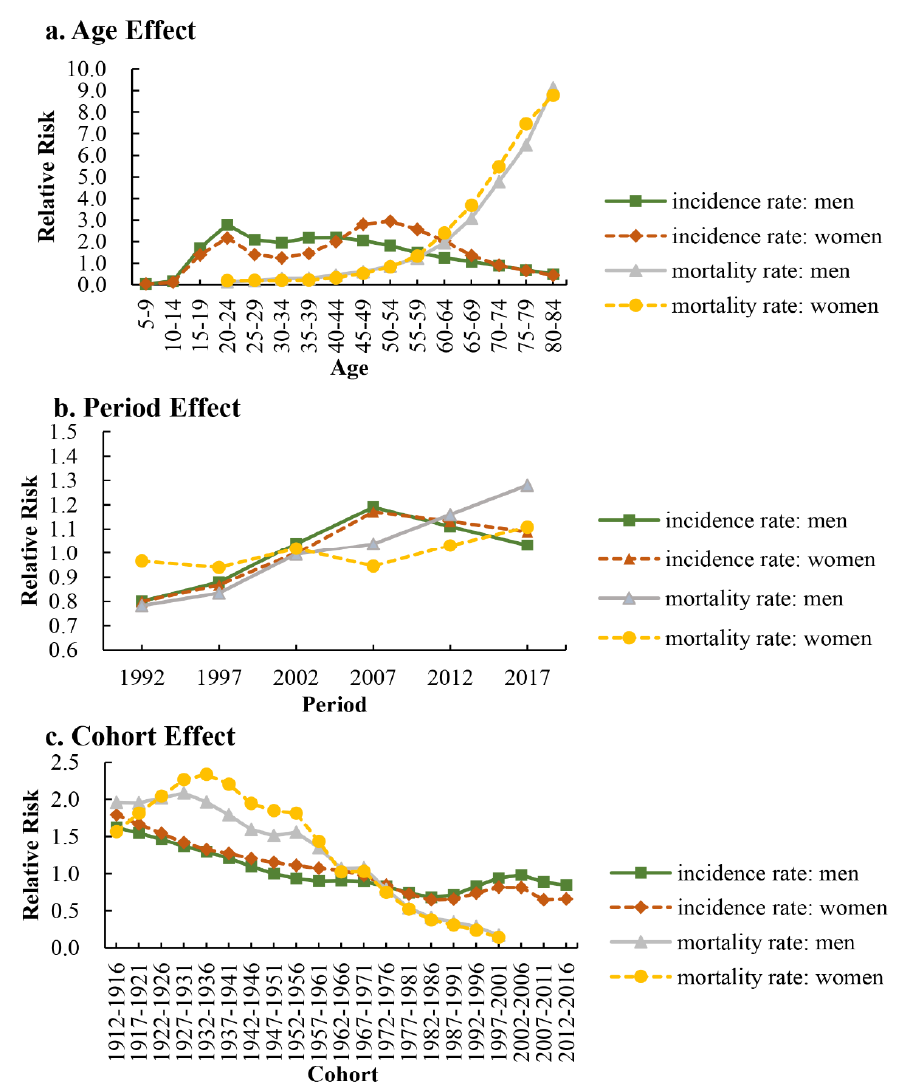
Figure 2 . The incidence and mortality relative risks of diabetes due to ( a ) age; ( b ) period; and ( c ) cohort effects. Table 2. The incidence and mortality relative risks of diabetes due to age, period, and cohort effects.